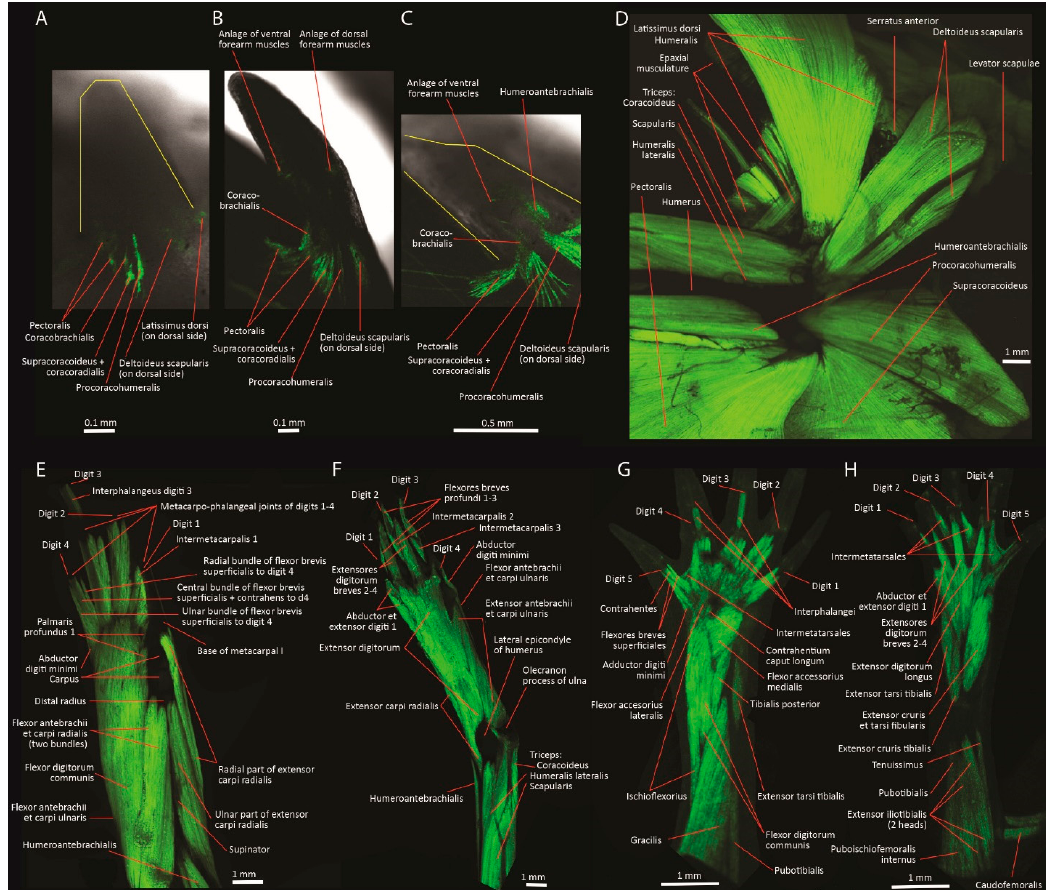
Figure 3. Transgenic axolotl ( Ambystoma mexicanum ) specimens that express GFP in muscle fibers. ( A – C ) show embryos; ( D – H ) show adults. Ventral views of right forelimb at stages mid-46 ( A ), early 47 ( B ), and mid-47 ( C ) (yellow lines show limits of the developing limbs); left lateral view of adult right forelimb after removal of the protractor pectoralis ( D ); adult left forelimb and hand in ventral ( E ) and dorsal ( F ) views; adult right hindlimb in dorsal ( G ) and ventral views. Modified from Diogo and Tanaka